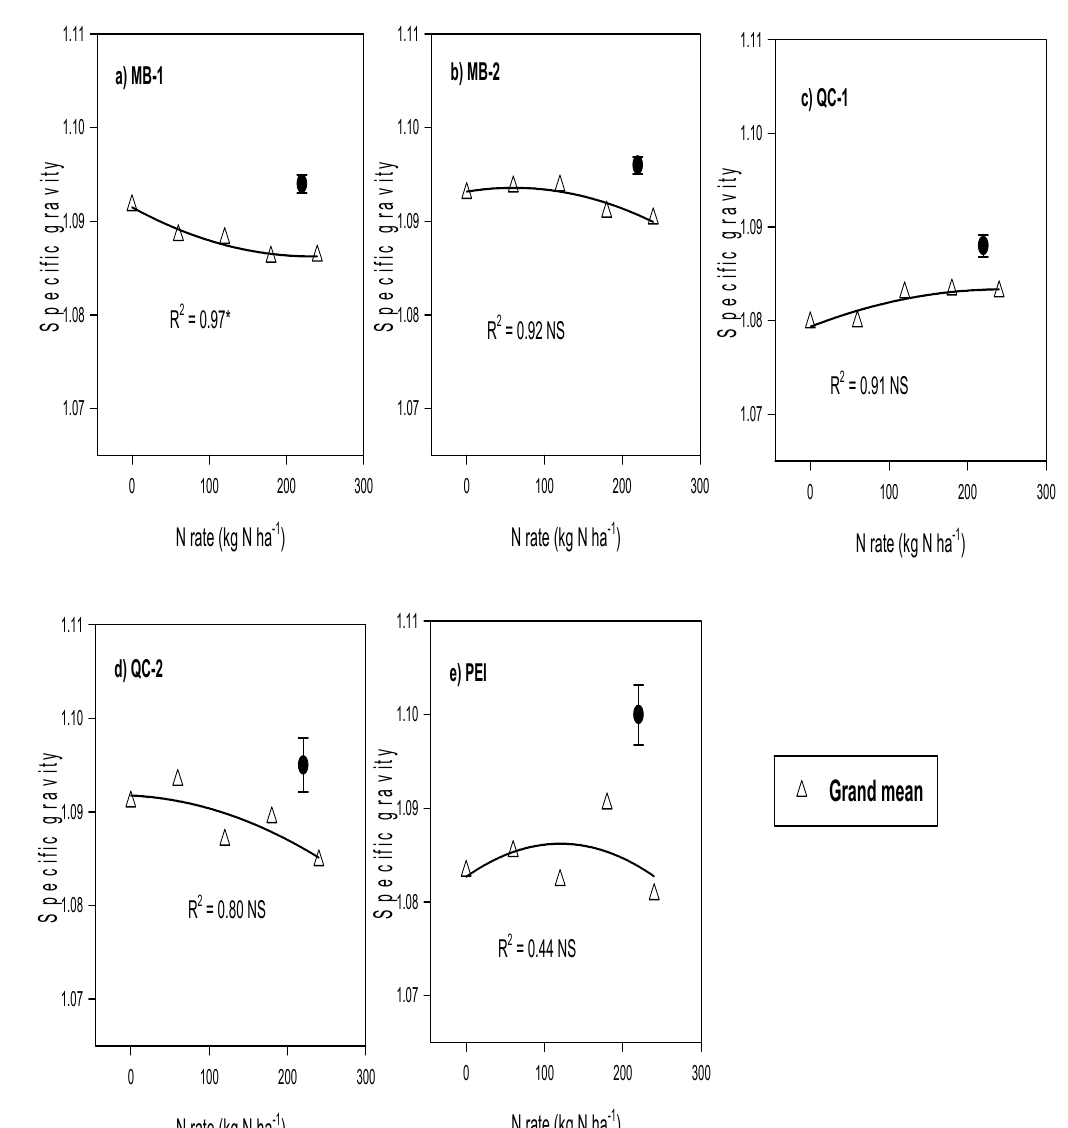
Figure 4. Specific gravity overall means versus N rate at: MB-1 ( a ), MB-2 ( b ); QC-1 ( c ), QC-2 ( d ) and PEI ( e ). Vertical bars represent the standard errors of the